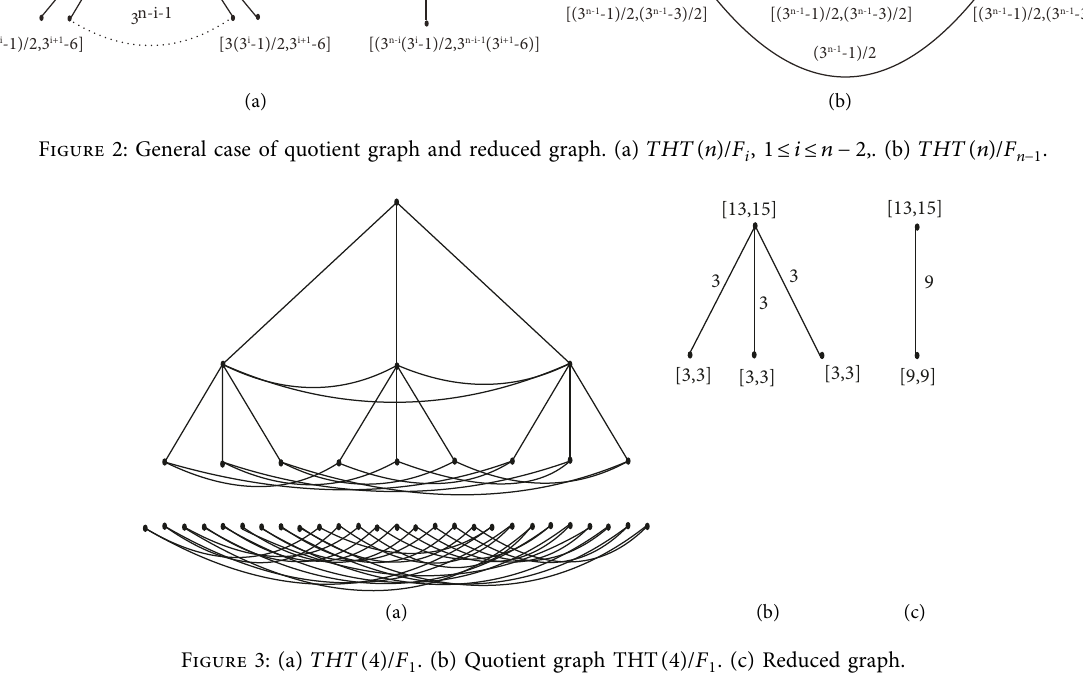
. (b) Quotient graph THT ( 4 ) / F 1